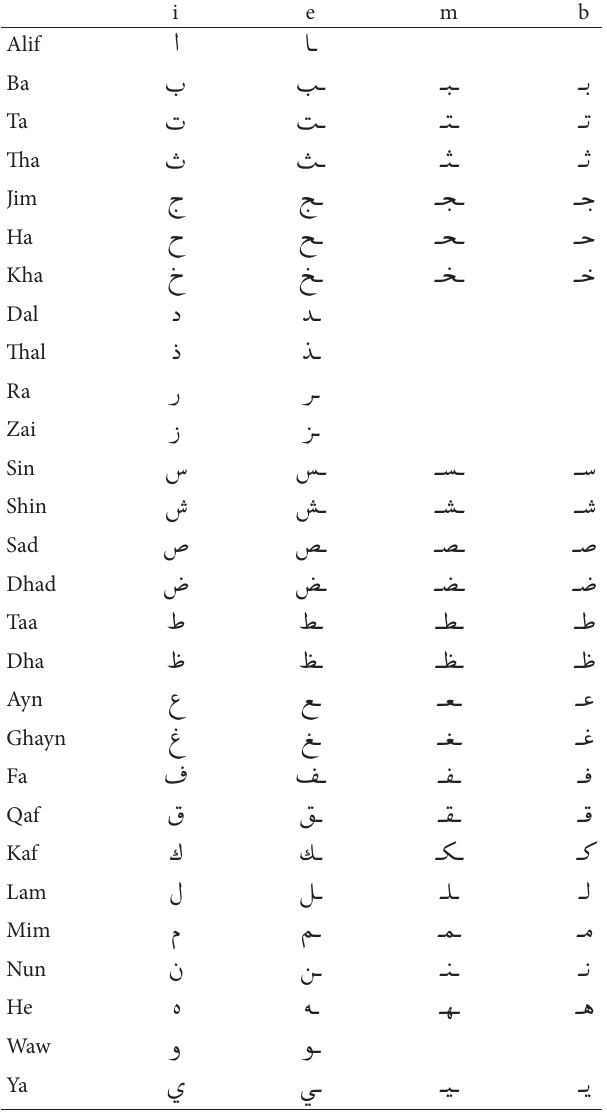
Table 1: Arabic alphabet, Naskh